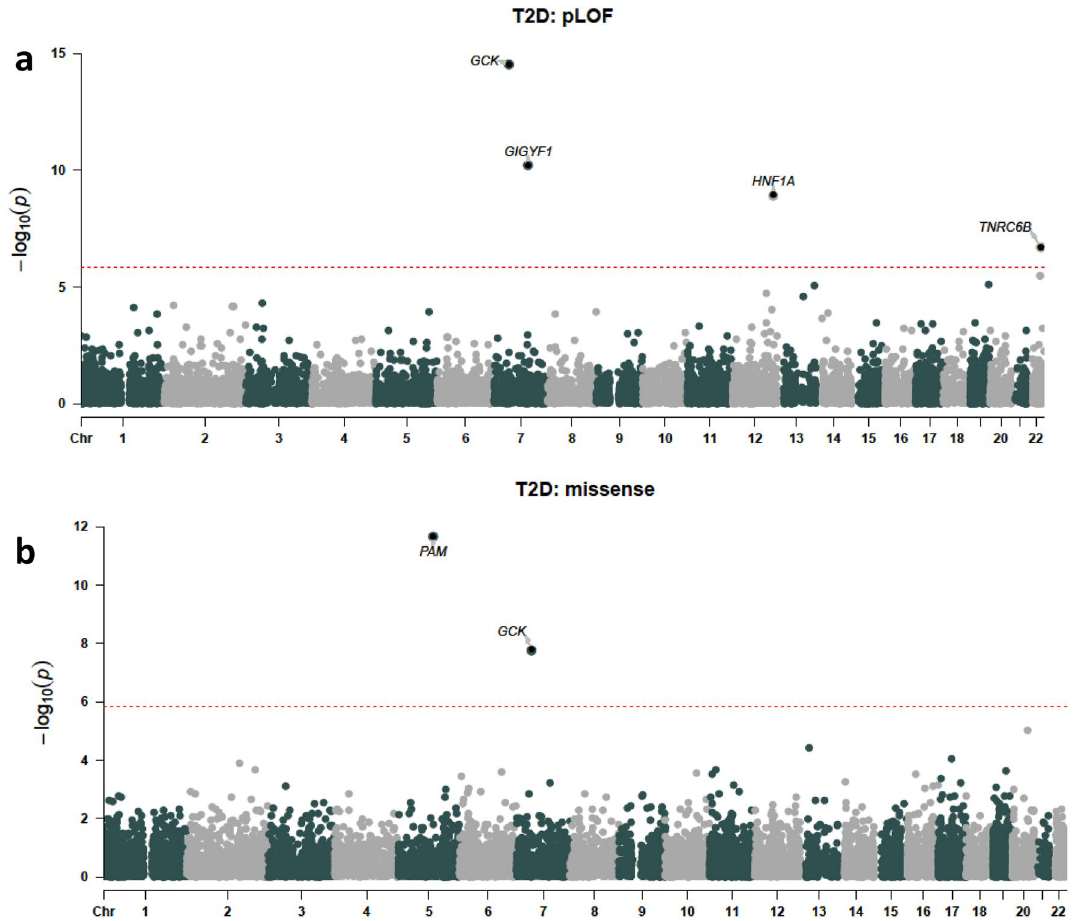
Figure 2. Gene-level associations with T2D. ( A ) pLOF associations. ( B ) Damaging missense variant (CADD score ≥ 25) associations. The red line indicates the threshold for significance, genes with significant associations are labeled.